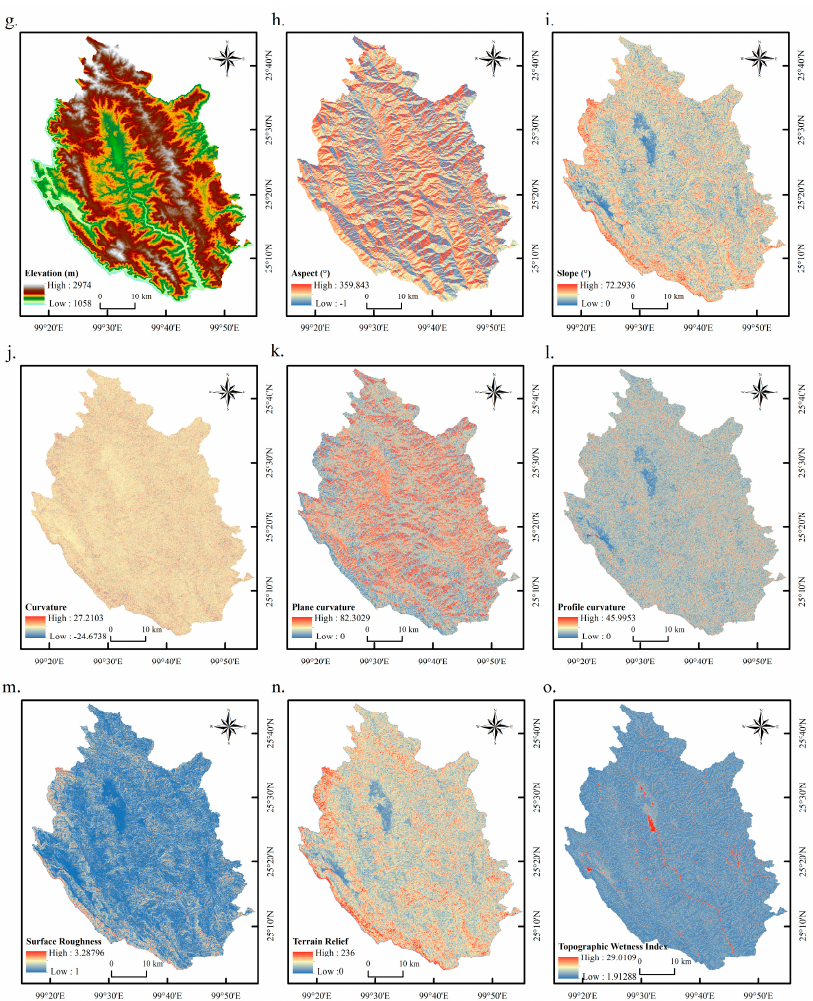
Figure 3. Landslide formation factors: ( a ) lithology, ( b ) distance from fault, ( c ) rainfall, ( d ) NDVI, ( e ) distance from road, ( f ) distance from river, ( g ) elevation, ( h ) aspect, ( i ) slope, ( j ) curvature, ( k ) plane curvature, ( l ) profile curvature, ( m ) surface roughness, ( n ) terrain relief, ( o ) Topographic Wetness